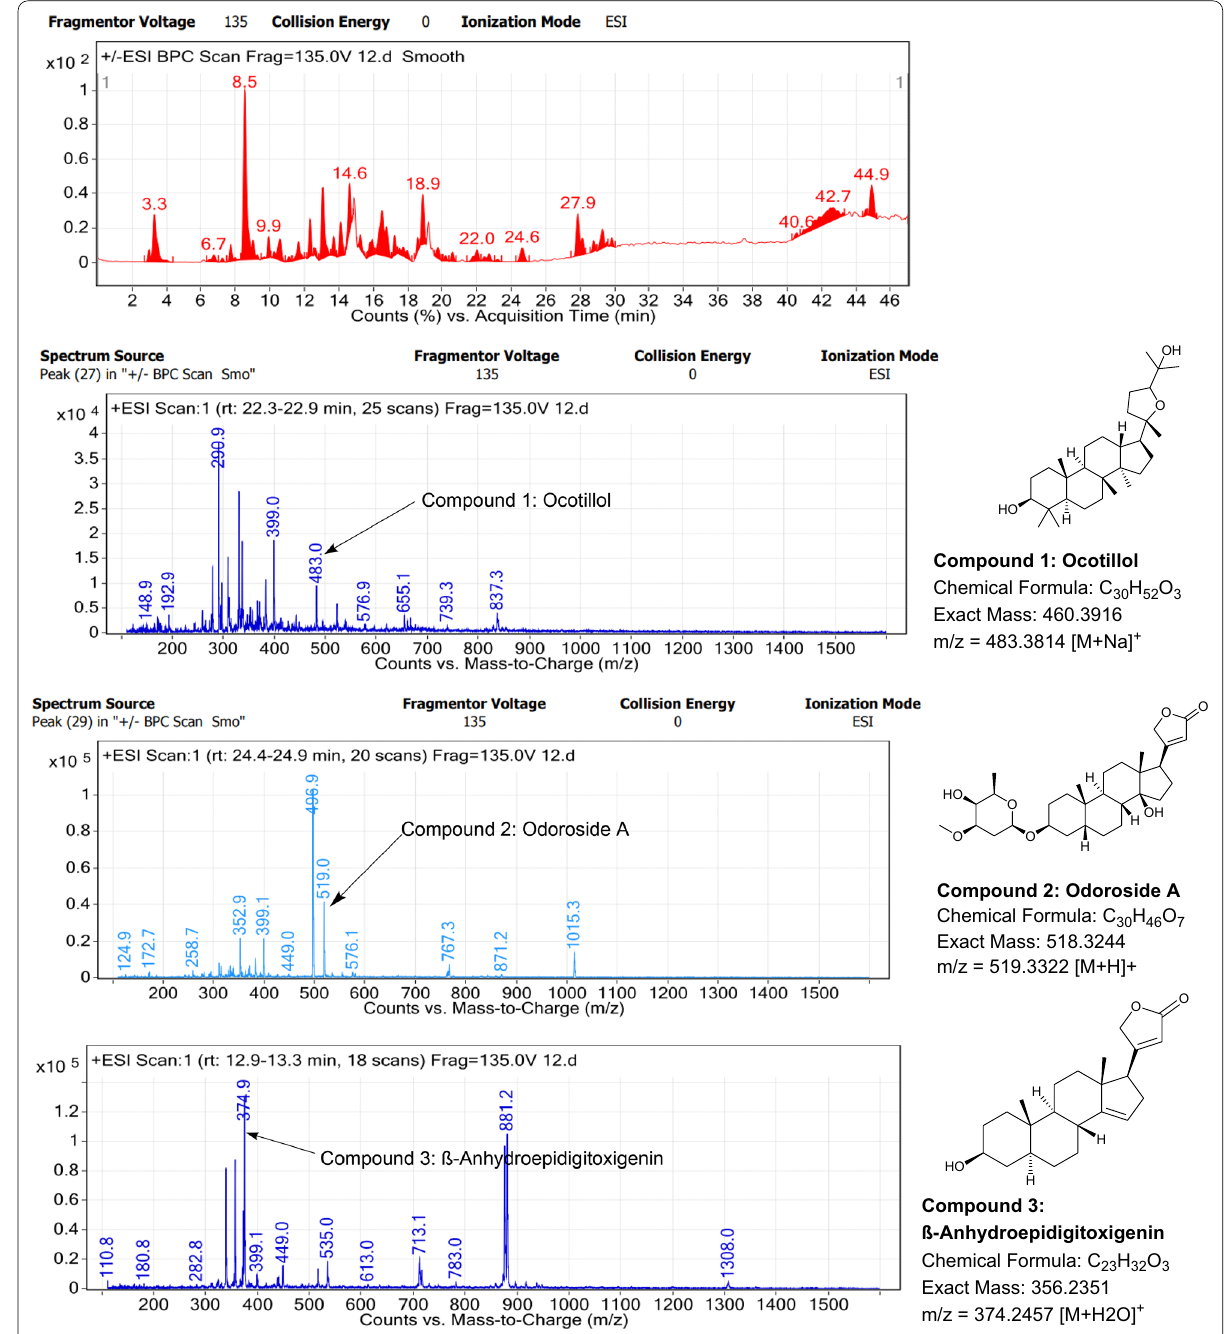
Fig. 18 LC–MS chromatogram of root extract of Nerium oleander showing marker